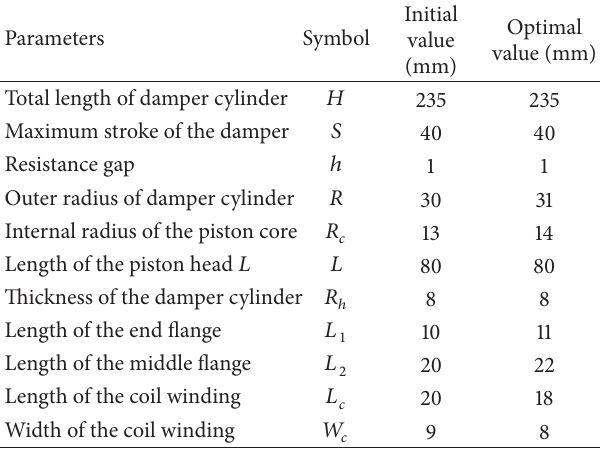
Table 3: Physical dimensions of the proposed double coil MR